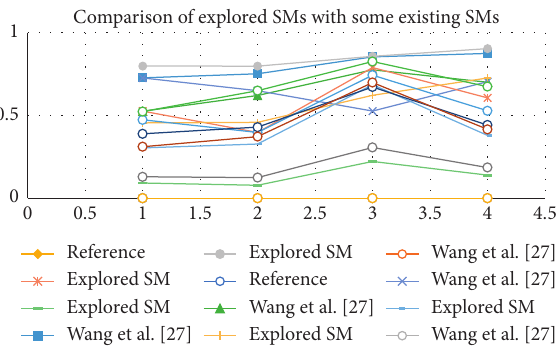
Figure 5: The graphical portrayal of the comparison of proposed and existing SMs for Example 5.